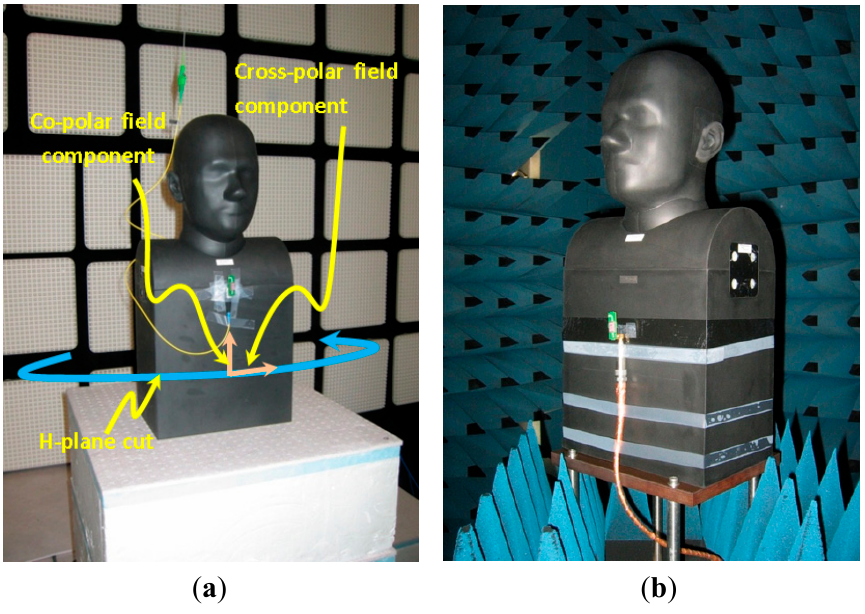
Figure 4. Photographs of the experimental setup for pattern measurements of the DRA with head and torso solid anthropomorphic phantom using: ( a ) fibre; ( b )